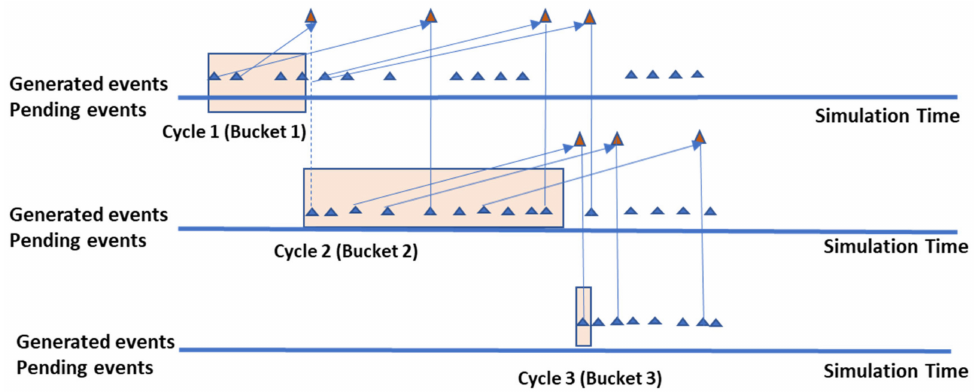
Figure 3. The event horizon for a single node and the insertion of events on the